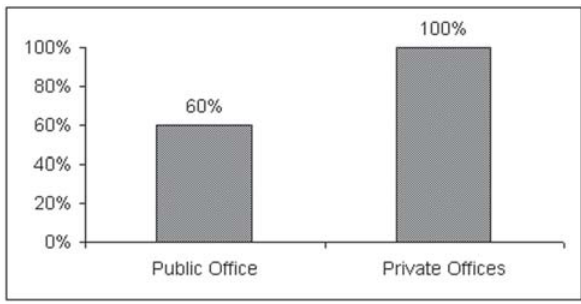
FIGURE 2- Distribution of dental professionals according to glove change between patients. Araçatuba/SP, 2003